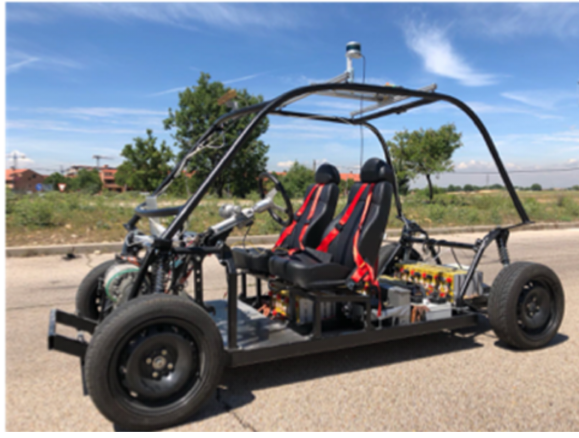
Figure 11. Car based on an Open Motors company TABBY EVO.